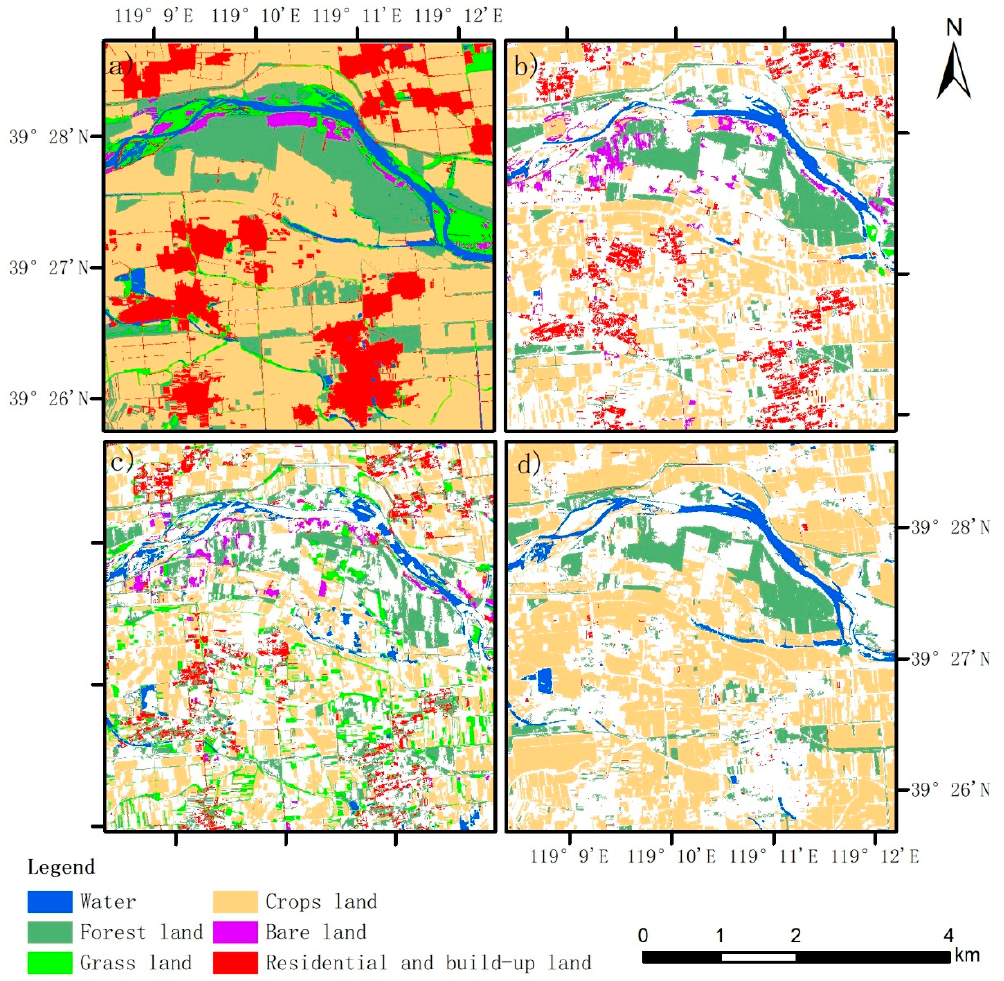
Figure 6. The validation area with original samples. The expert interpreted land cover result is shown in ( a ). The sample augment results of NNSA, label propagation (LP), and DNN are shown in ( b ), ( c ), and ( d ), respectively.